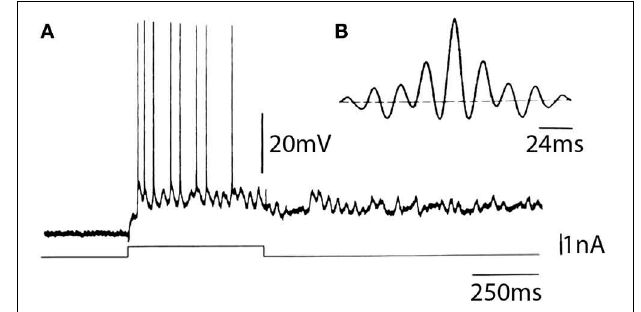
FIGURE 13 | In vitro intracellular recording from a sparsely spinous neuron of the fourth layer of the frontal cortex of guinea pig. (A) Characteristic response obtained in the cell following direct depolarization, consisting of sustained subthreshold oscillatory activity on which single spikes can be observed. (B) Autocorrelogram of the intrinsic oscillatory frequency indicated a 42Hz intrinsic oscillation (Llinás et al.,